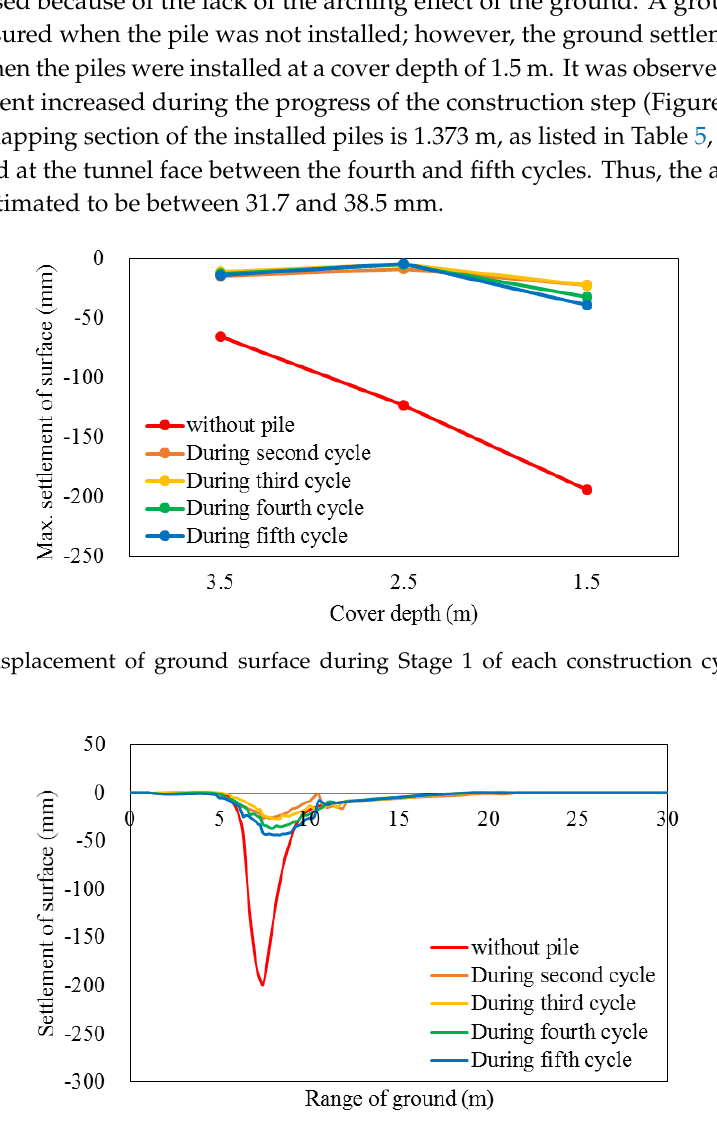
Figure 15. Ground displacement during Stage 1 of each construction cycle.